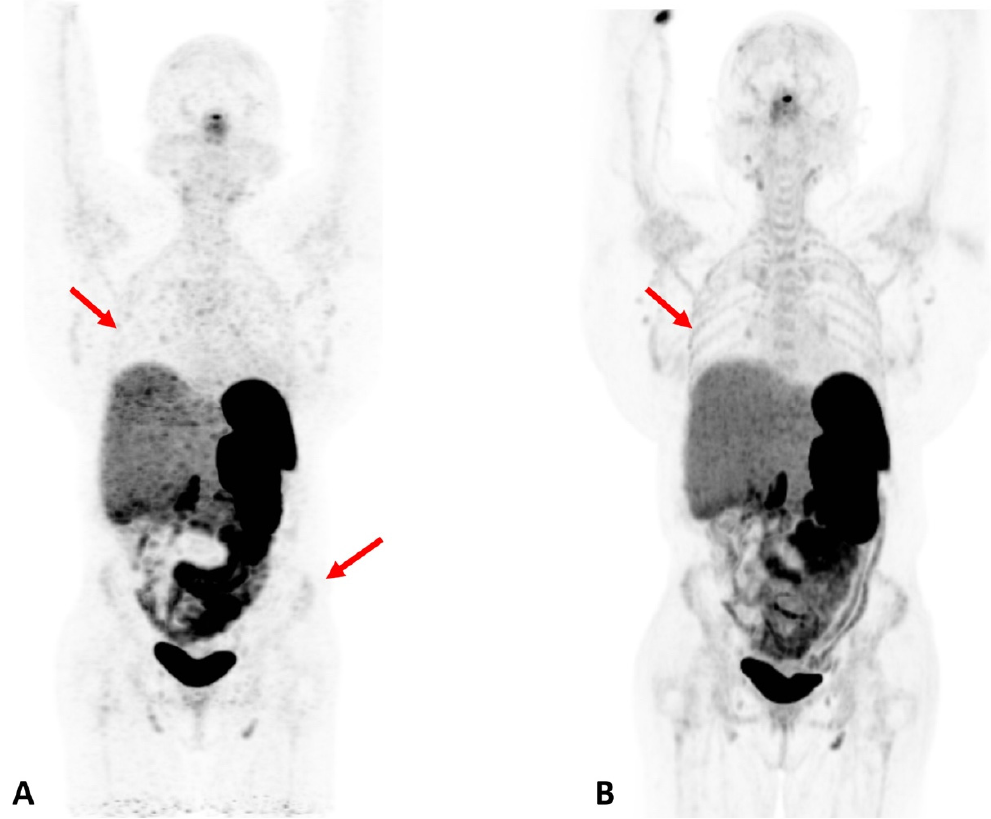
Figure 4. Patient with Cushing Syndrome post bilateral adrenalectomy. A dose of 167 MBq of 68Ga DOTATATE was injected, and a 20-min scan was performed after 60 min of uptake. ( A ) Baseline scan obtained on a conventional PET/CT scanner; ( B ) 6-month follow-up scan obtained on a total-body scanner. In the total-body PET/CT image, background noise is lower and the signal higher, allowing for clearer visualization of the liver. In addition, the increased signal level on the total-body scanner results in new or better visualization of bone details (arrows). Reprinted with permission from Ref. [23]. Copyright 2020 Elsevier.